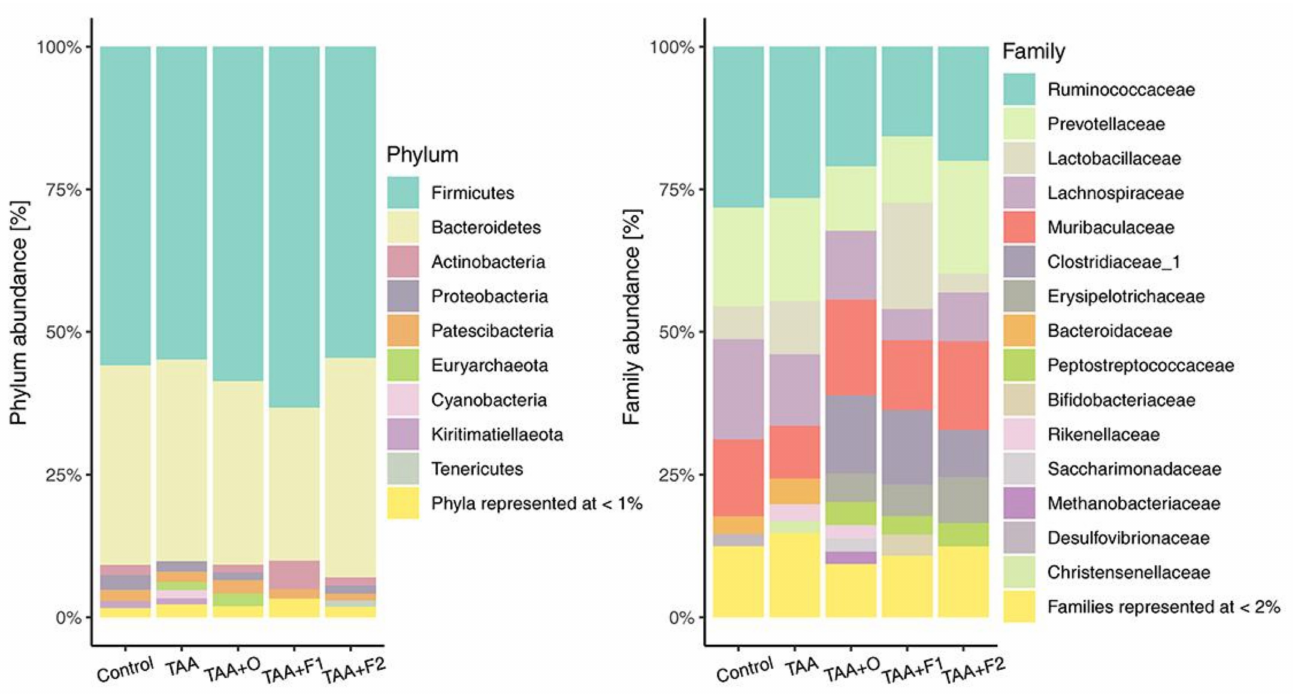
Figure 6. Percentage abundance on phylum ( left ) and family ( right ) level in control, and rats treated with thioacetamide (TAA), thioacetamide + virgin olive oil (TAA+O), thioacetamide + C60 fullerene lower dose (TAA+F1), and thioacetamide + C60 fullerene higher dose